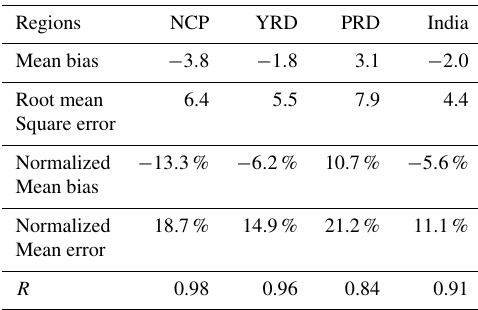
Figure 3. Scatterplot of simulated and observed seasonal mean ozone concentrations for winter (a) , spring (b) , summer (c) , and autumn (d) . Table 2. Model evaluation